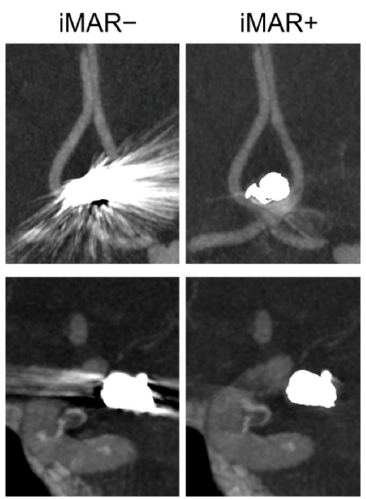
Figure 5. Side ‐ by ‐ side examples of FD ‐ CTA images without/with application of the iMAR (iMAR − /iMAR+) in patients with treated intracranial aneurysms via endovascular coiling. Upper row shows a patient with a treated aneurysm of the anterior communicating artery, basal row shows a patient with a treated aneurysm of the internal carotid artery. In the iMAR − images of both cases, the parent vessels are not (upper case) or poorly differentiable (basal case), whereas in the iMAR+ images, the parent vessels are very well